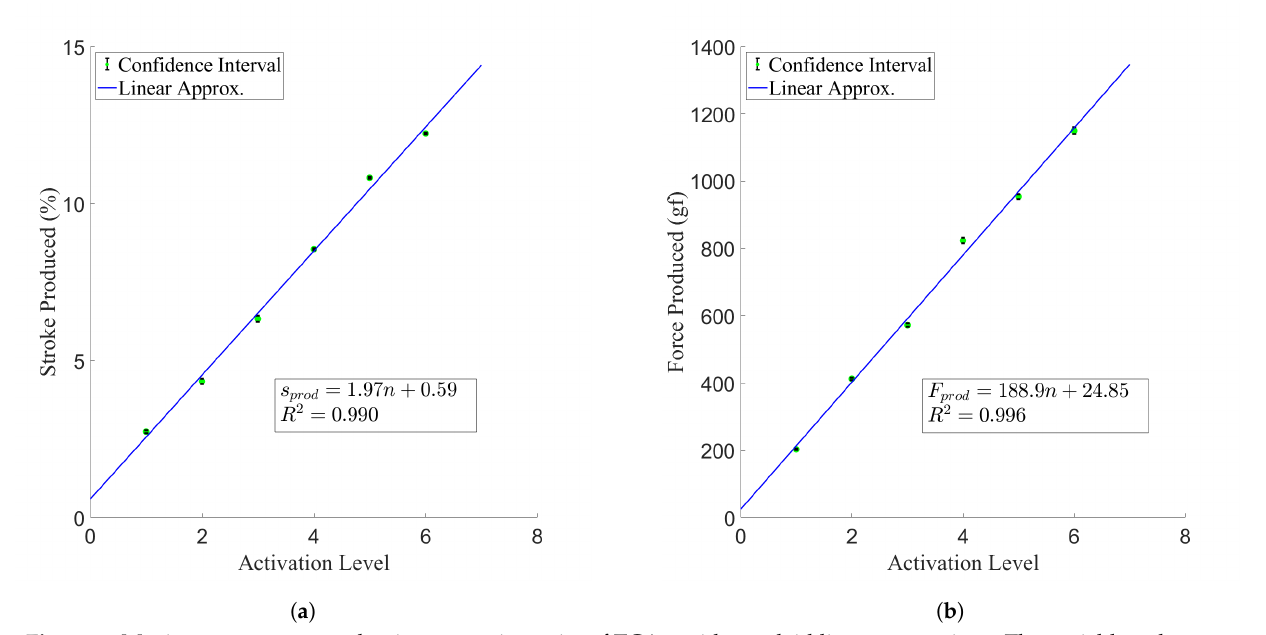
Figure 9. Maximum actuator production per active pairs of TCAs, with overlaid linear regressions. The variable n denotes the number of activated pairs of TCAs. ( a ) Stroke production results. ( b ) Force production